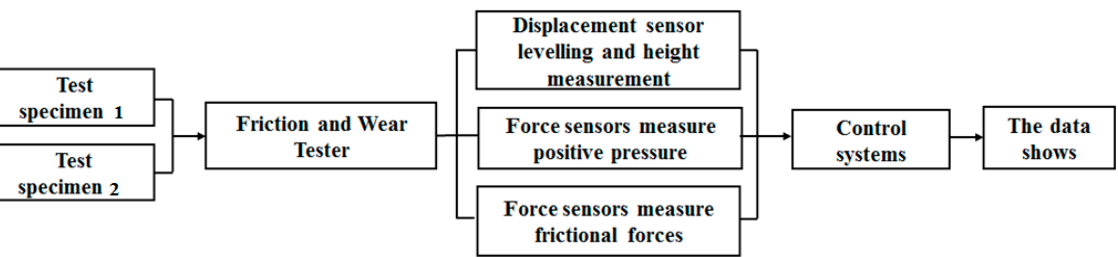
Figure 12. Experimental flow diagram of the new friction and wear tester.